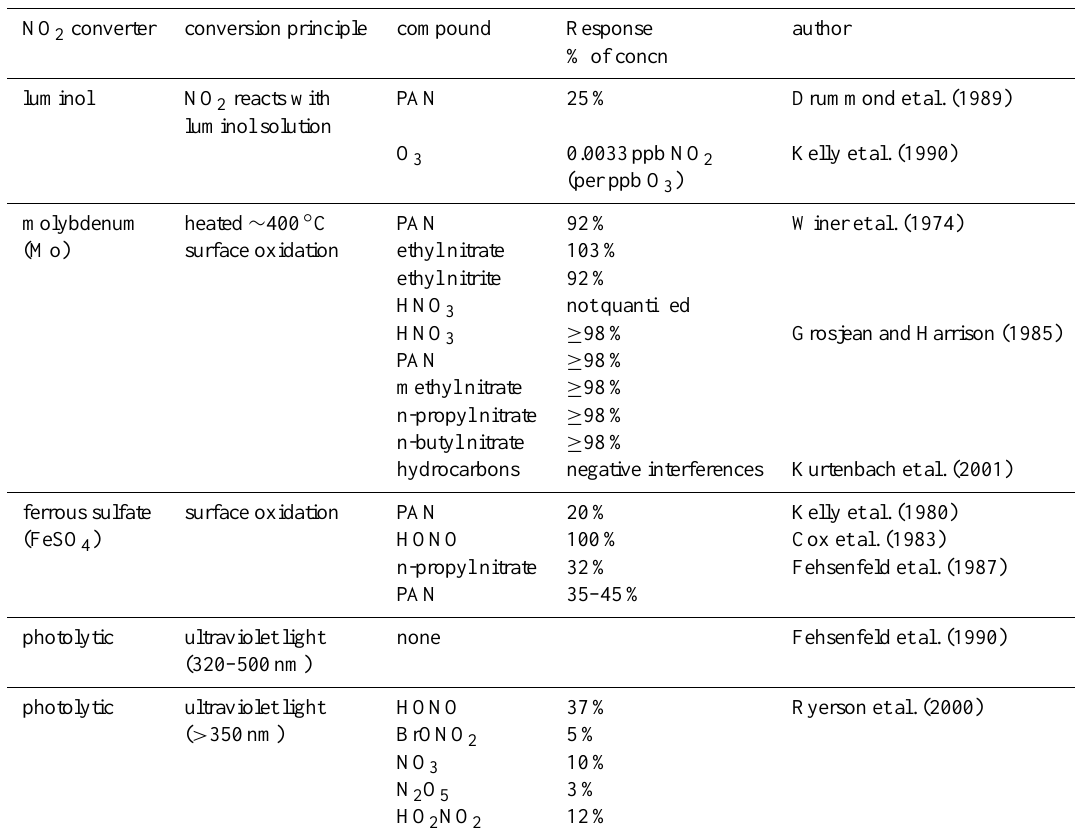
Table 2. Interferences of chemiluminescence NO-NO 2 -NO x analyzers using different NO 2